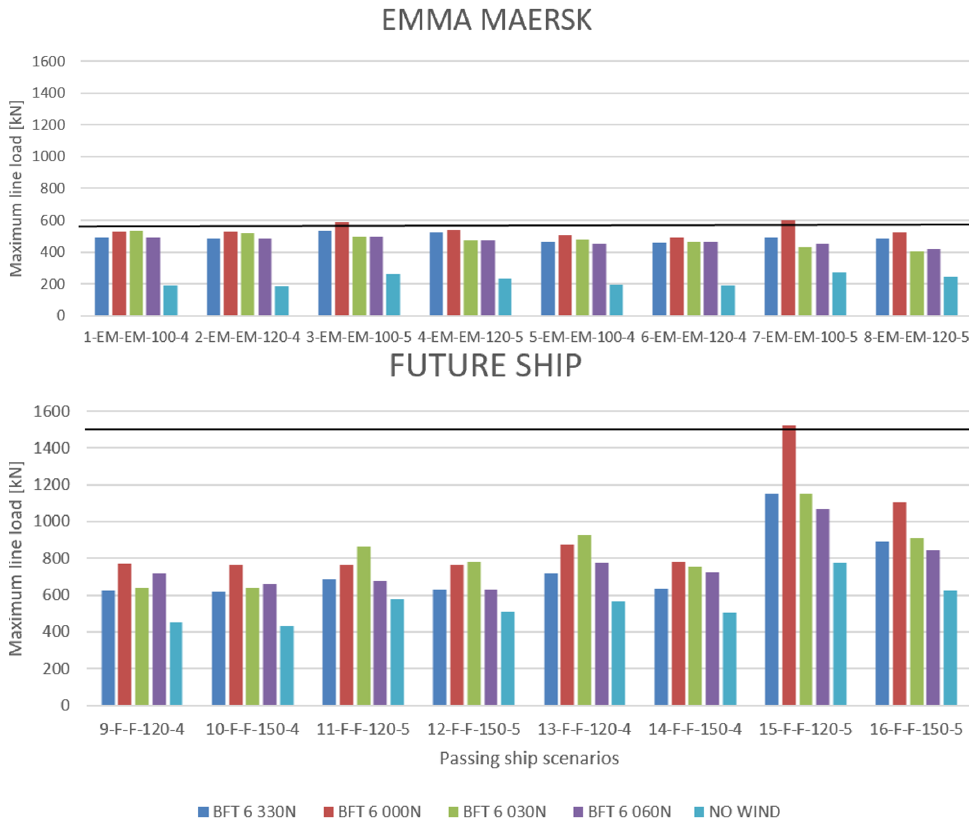
Figure 17. Maximum line load results for the Emma Maersk and future vessel subjected to passing- ship